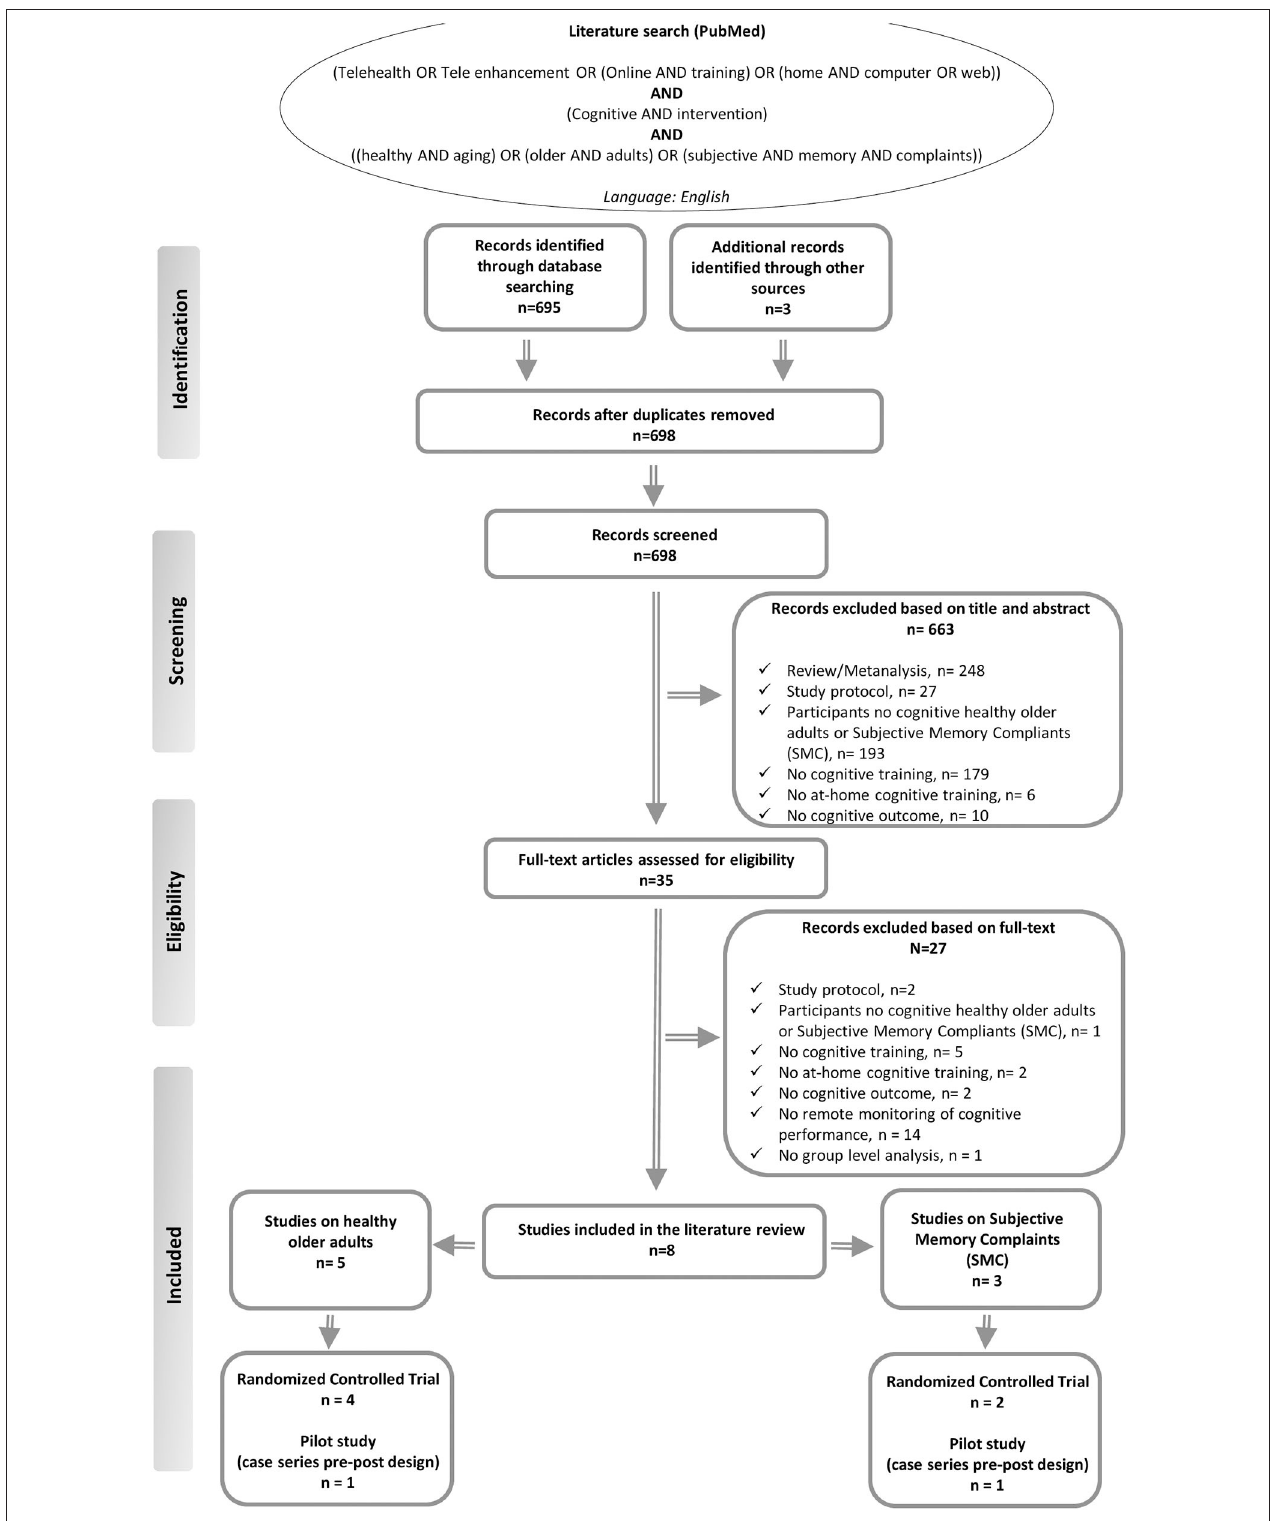
FIGURE 1 | Summary of the literature search—PRISMA flow diagram (48).